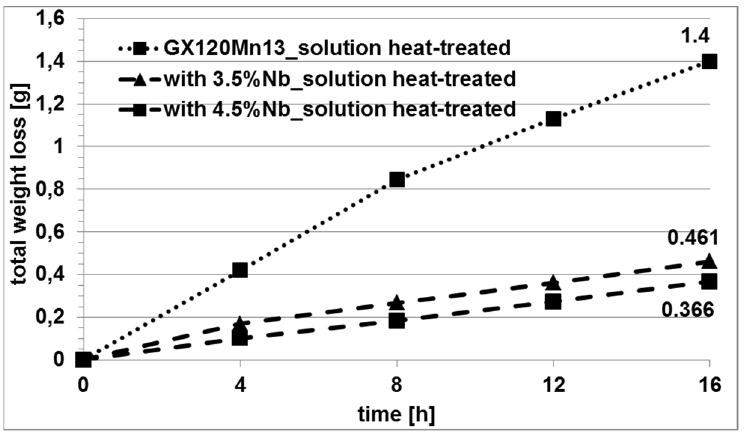
Figure 13. Abrasive wear response of Hadfield cast steel vs. tested high-manganese cast steel with Nb addition.